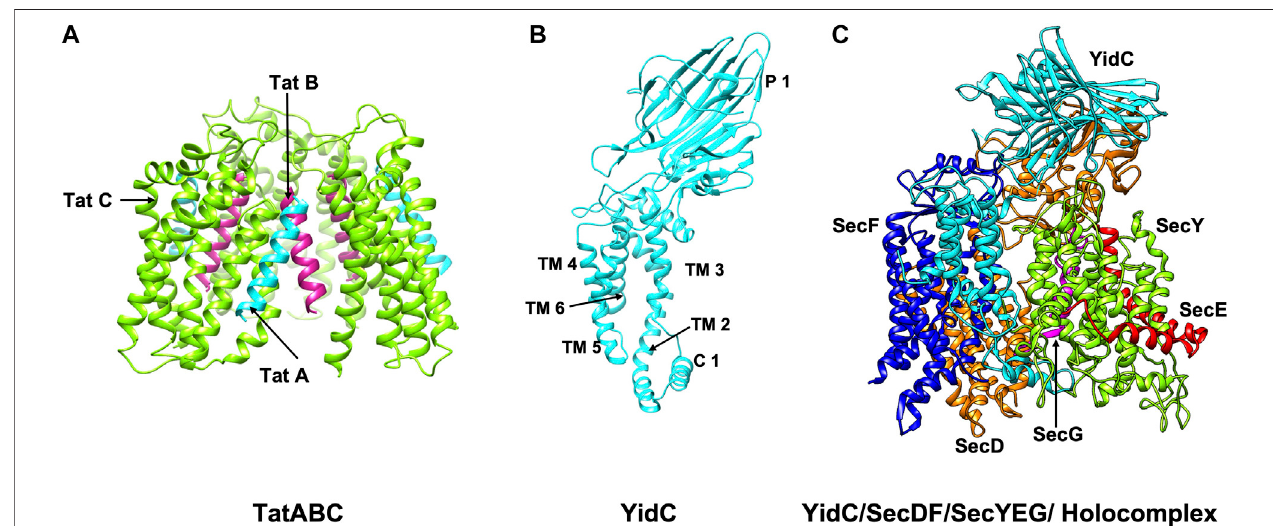
FIGURE3| Thestructures/modelsofthebacterialexportand insertionmachineries. Exportofproteinsacrossthemembrane arecatalyzedby (A) theTatcomplex (restingcomplexshown) inafoldedstate (left side) (Habersetzer etal., 2017)or (C) bySecYEG/SecDF/YidC [adapted fromBotte et al.(2016) PDB: 5MG3] energized by the SecA motor ATPase (not shown) in an unfolded state. TatA, TatB and TatC is shown in cyan, magenta and green, respectively. SecY, SecE, and SecG is shown in green, red, and magenta; SecD, SecF and YidC are shown in orange, blue and cyan. Membrane protein integration is catalyzed by the SecYEG/SecDF/YidC (C) complex or by the YidC insertase (B) [adapted from Kumazaki et al. (2014b) PDB: 3WVF]. The view is in the plane of the membrane with the periplasmic face at the top and the cytoplasmic face at the bottom.